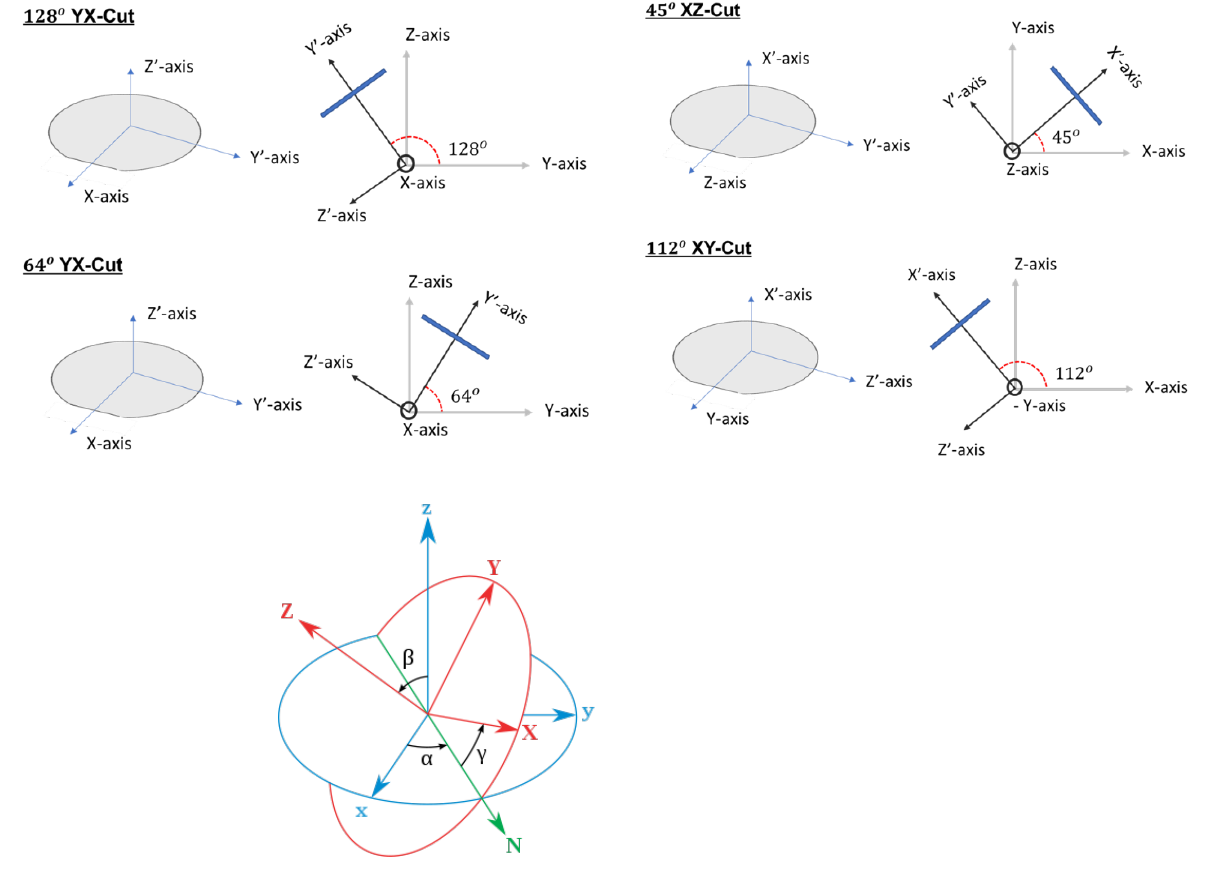
Figure 8. Different orientational cuts of the Lithium Niobate crystal ( top ) and the Eulerian angles ( bottom ). Table 3. Description of different piezoelectric materials and their cuts for specific wave